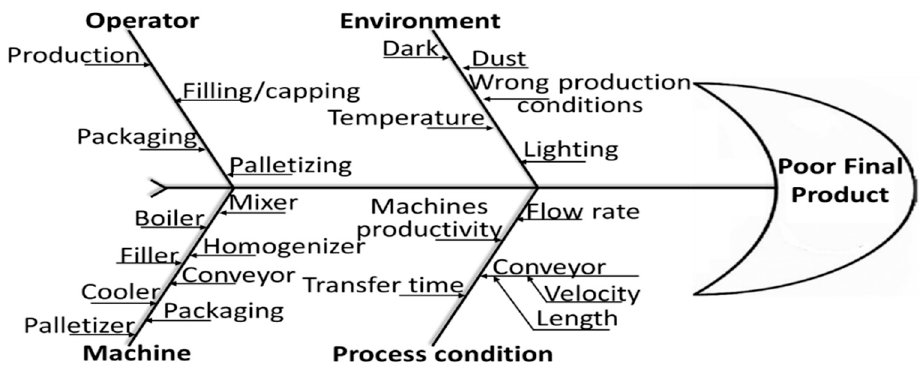
Figure 5. Cause-causality diagram for bo tt leneck parallelization to control factors.